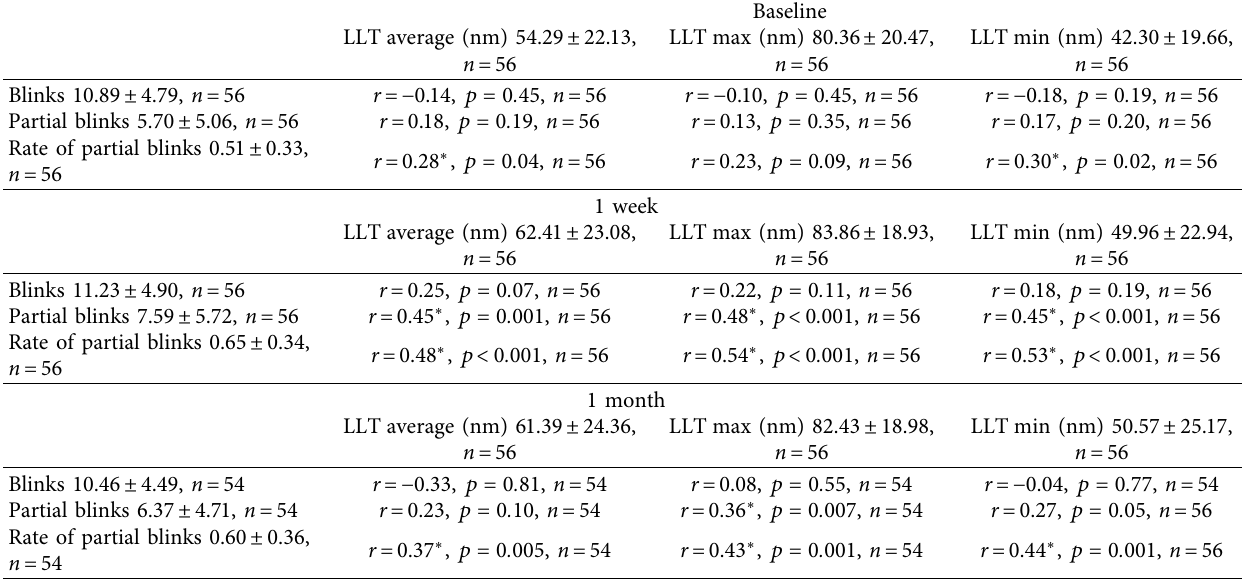
Table 3: LLT (average, minimal, and max) and blinking pattern of 56 OK eyes at baseline.